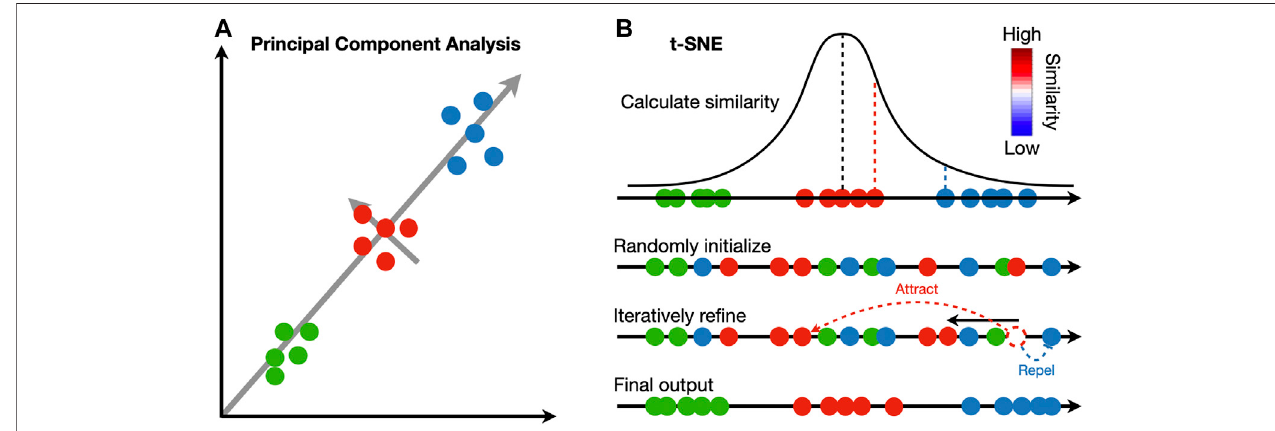
FIGURE 2 | Comparison between principal component analysis and t-SNE. (A) Principal component analysis iteratively identi fi es vectors that minimize the sum of squared distances to the direction of the vector. Each vector is orthogonal to all previously selected vectors. (B) t-SNE calculates a pairwise similarity based on the probabilitydensityfunctionoftheGaussiandistributionintheoriginalhighdimensionspace.Thepointsarerandomlyprojectedtoalowdimensionalspaceanditeratively re fi ned so that the similarity in low dimension matches that in high dimension. At each iteration, similar pairs attract, and dissimilar pairs repel each